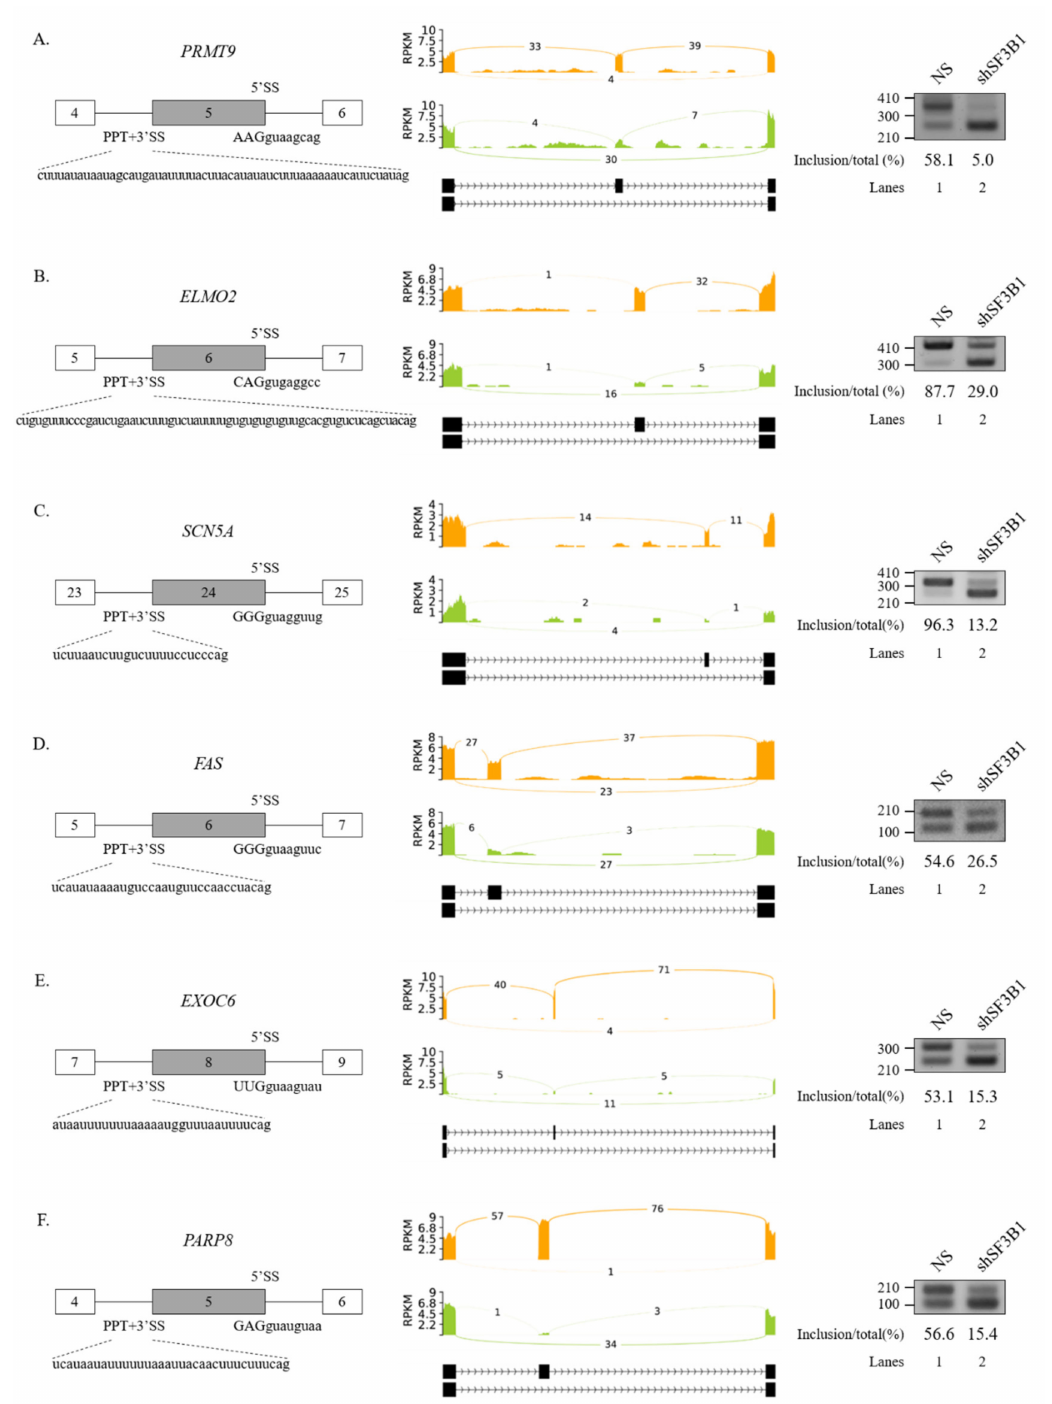
Figure 2. Validation of regulated SEs in SF3B1 KD cells. ( A – F ) (Left) Schematic representation of alternative exons in genes. Sequences of 5 (cid:48) SS, 3 (cid:48) SS, and PPT of cassette exons are shown. (Middle) Sashimi plots of validated SEs in RNA-seq. (Right) RT-PCR analysis of altered SEs in SF3B KD cells vs. control